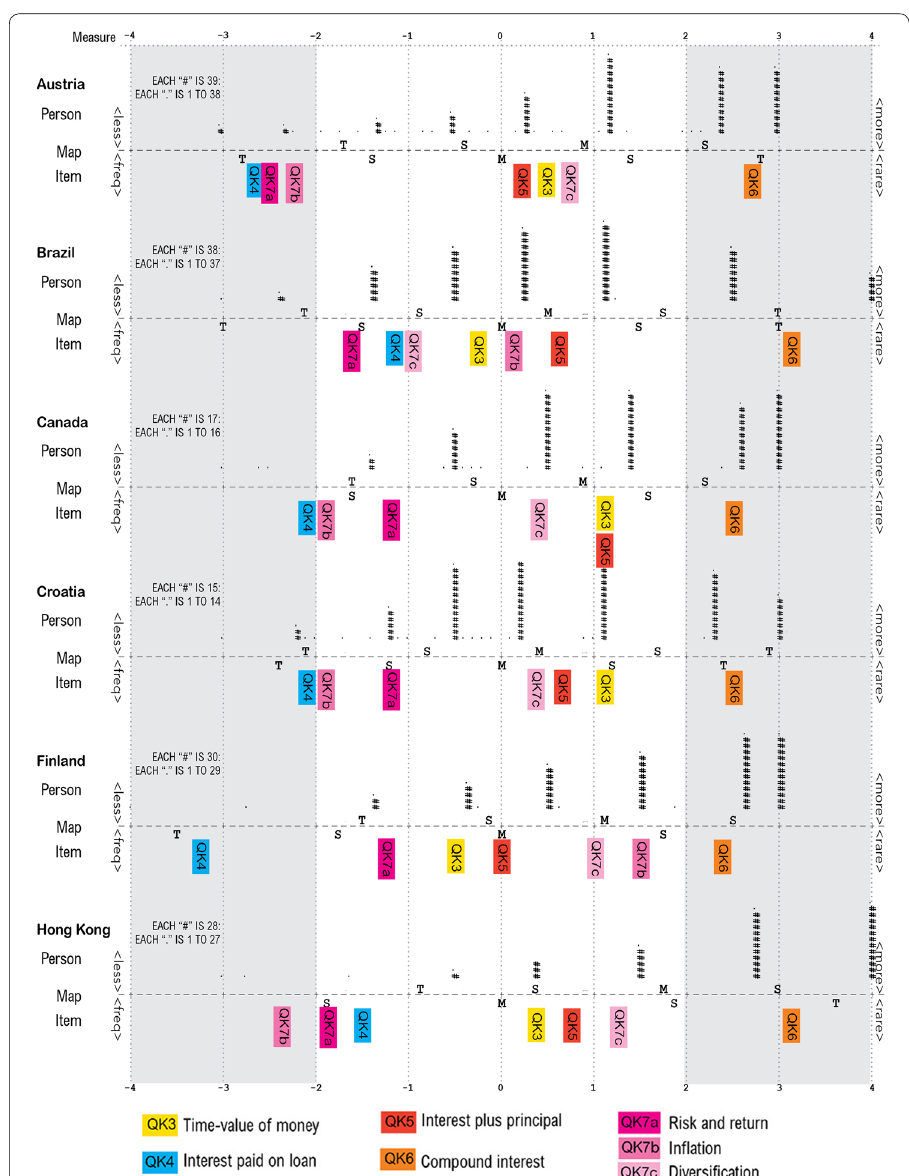
Fig. 3 Wright maps: financial knowledge assessment. Wright maps portray the two dimensions of (i) ability of the respondents and (ii) difficulty of the questions on one illustration. The placement of the respondents ability compared to the difficulty of the questions give an indication of how closely (or not) the participants abilities are compared to the difficulty of the measurement